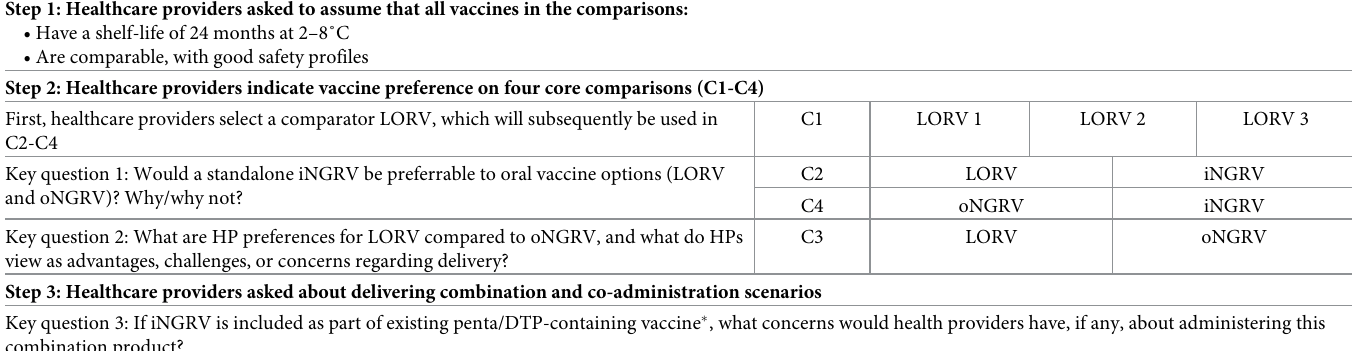
Table 3. Summary of vaccine comparisons & delivery